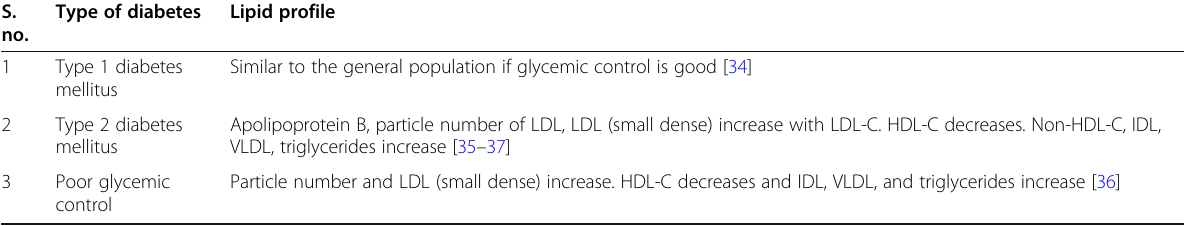
Table 2 Lipid abnormalities in diabetic patients S.